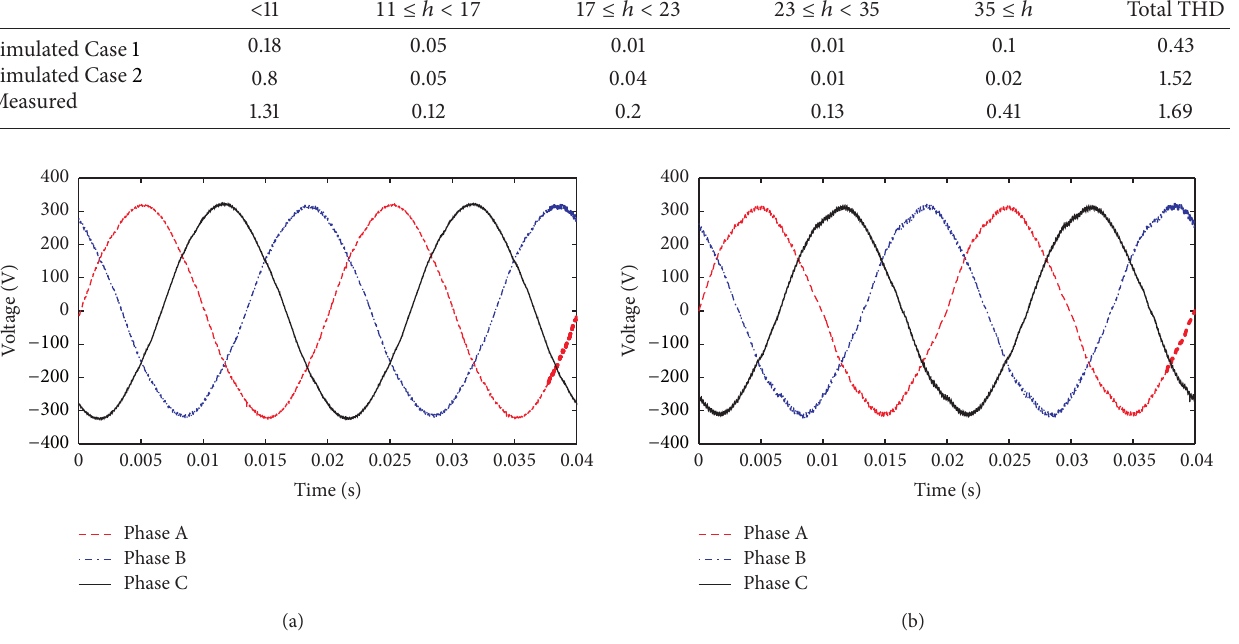
Figure 10: Phase voltages across the load at nominal power from the experimental setup. (a) The voltage with the lowest THD. (b) The voltage with the highest